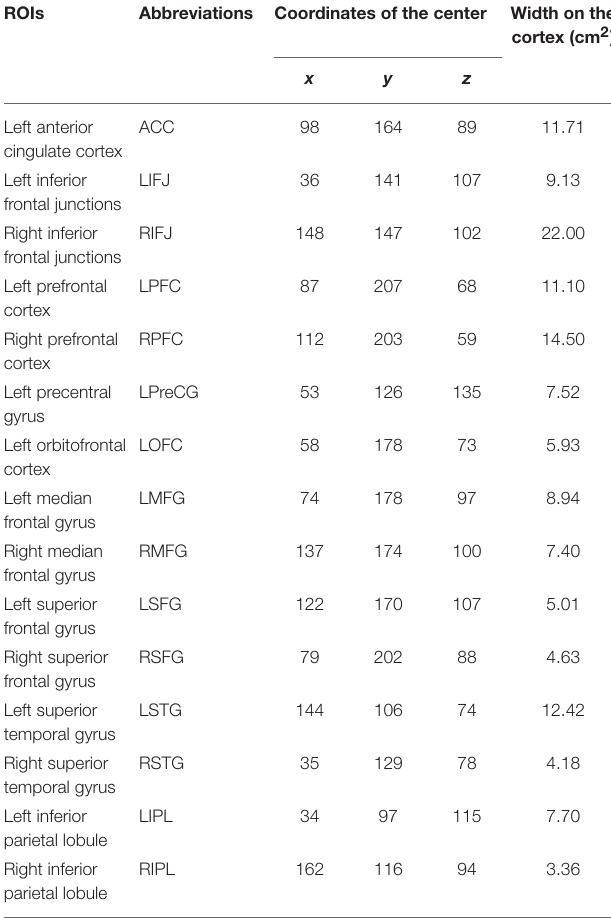
TABLE 3 | Coordinates of the brain activations over periods of 50ms ( − 400 to 1,500ms after presentation of the problems), defined using the Desikan Atlas (Desikan et al.,